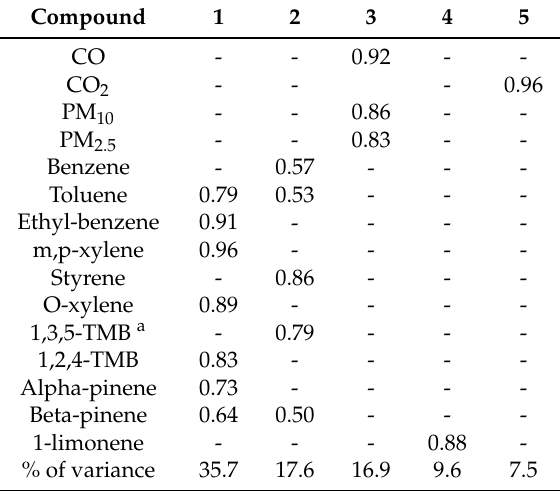
Table 6. Results of factor analysis by principal component